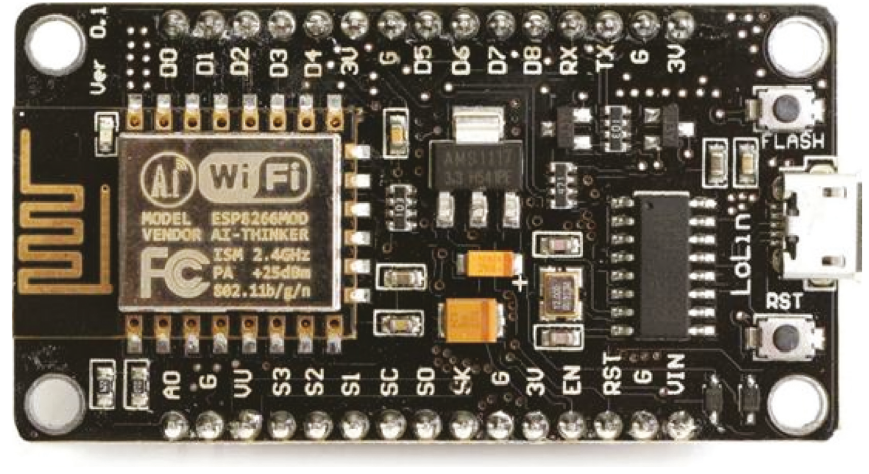
Figure 3: Arduino board.